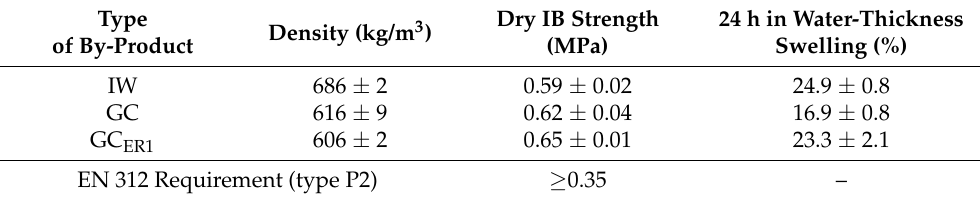
Table 8. Results of particleboards bonded with MFU resin and with recycled